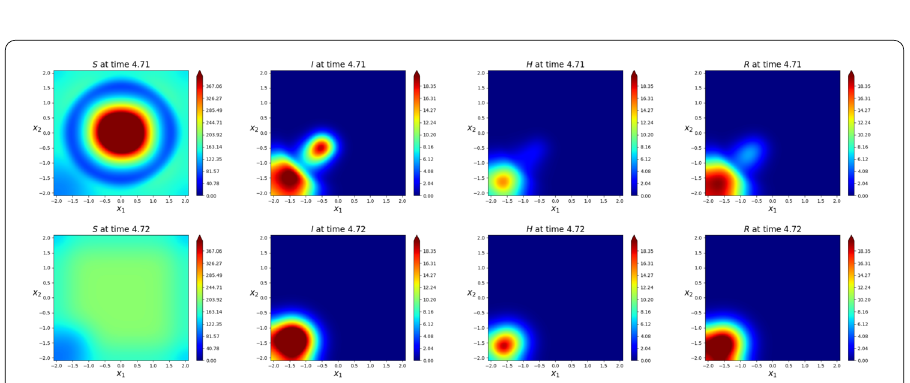
Figure 16 Contour plots of the solution to (8) at time, above, t = 4.71 and, below, t = 4.72, roughly corresponding to 5 p.m. of the 4 th day. Above, the case with the commuters’ movement (15), below the case with no movement. Apart from the spreading of the virus in the bottom left corner, the S distribution in the line above is symmetric w.r.t. the origin, while on the line below it is uniform. Here, differences in the